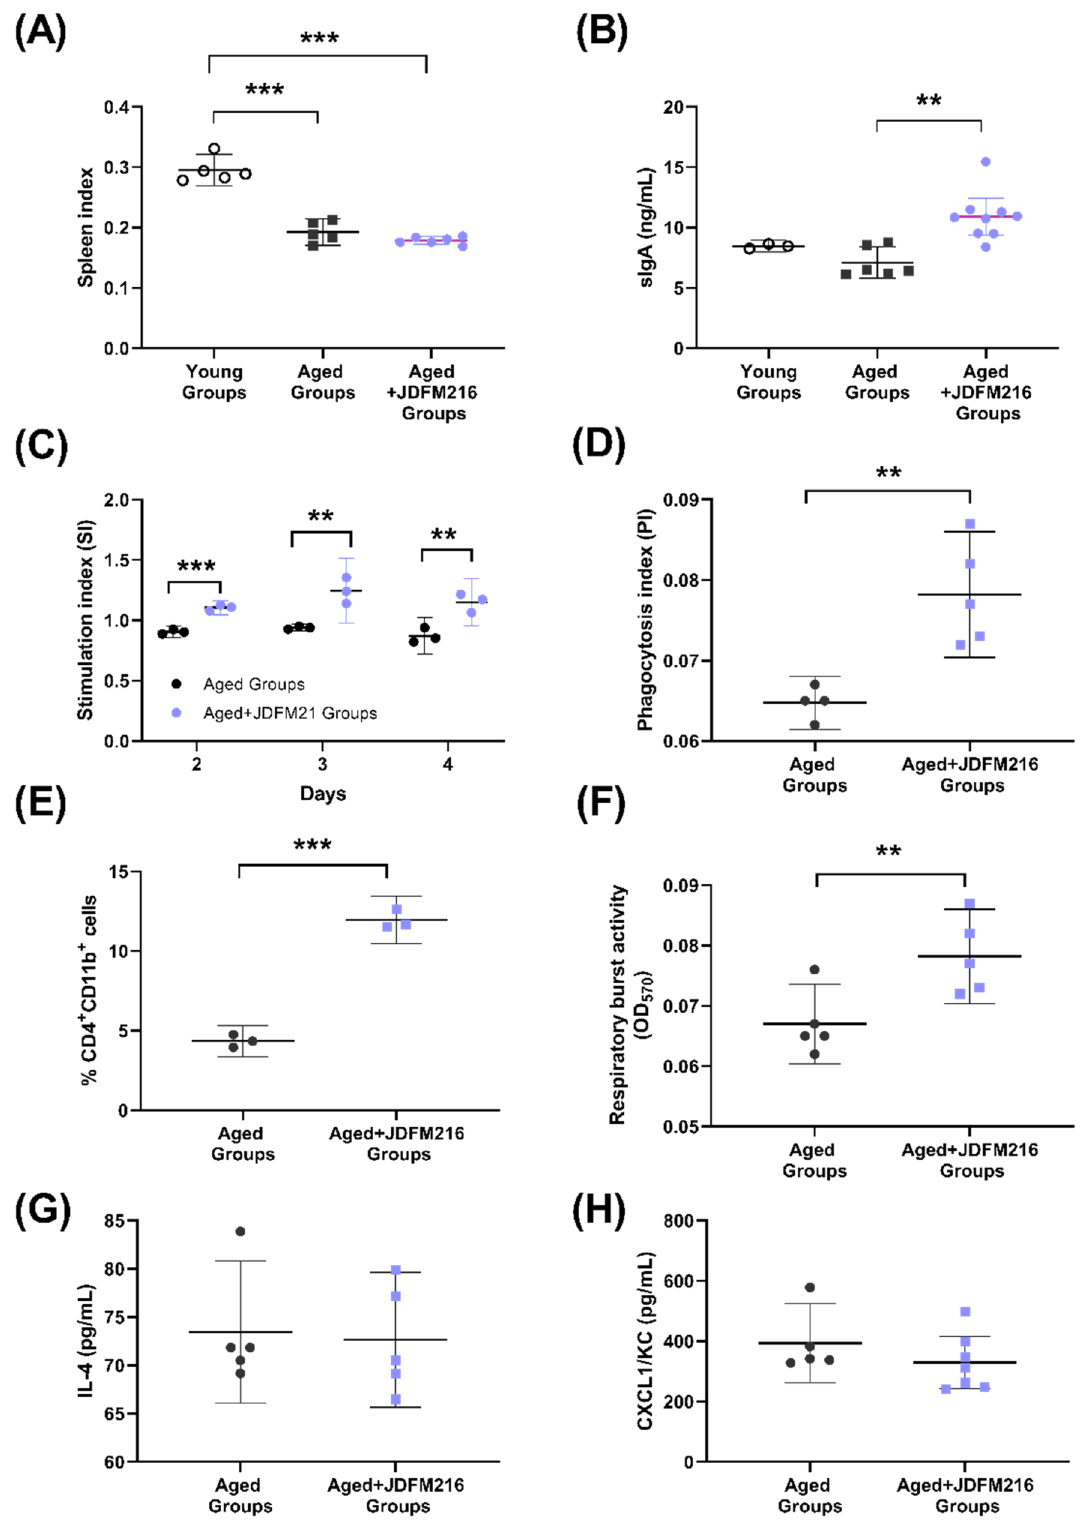
Figure 2. Profiling of the immune response in JDFM216-treated aged mice. ( A ) Spleen indices of young and aged mice (Young Groups, Aged Groups or Aged + JDFM216 Groups). ( B ) Secretary immunoglobulin A (sIgA) production in the intestine. ( C ) Proliferation of splenocytes. The proliferation was measured at 48, 72, and 96 h of cultivation. ( D ) Pinocytosis of peritoneal macrophages. ( E ) CD11b and CD4 expression on the surface of dendritic cells. ( F ) Leukocyte respiratory burst activity. Cytokine IL-4 and chemokine CXCL1 levels. ( G , H ). The young mouse group was used at 8 weeks of age. Values are means ± SD. Asterisks represent statistically significant differences; one-way ANOVA was performed. * P < 0.05; ** P < 0.01; *** P < 0.001, compared with the